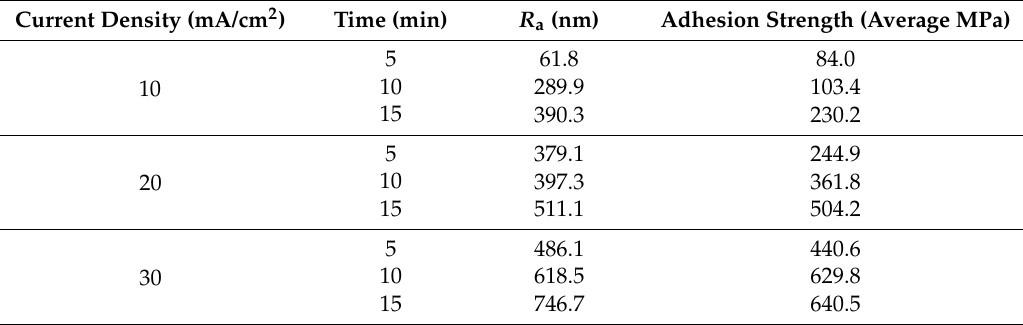
Table 1. The roughness and adhesion strength of the Ni laminated films treated by anodic